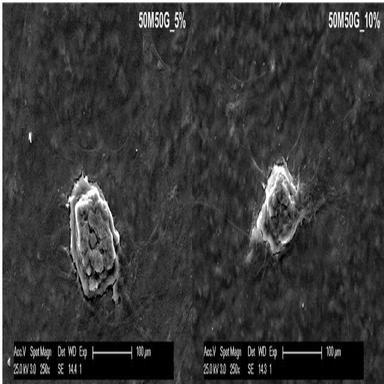
SEM images of the HFBs multilayered aggregates grown onto substrate surfaces.